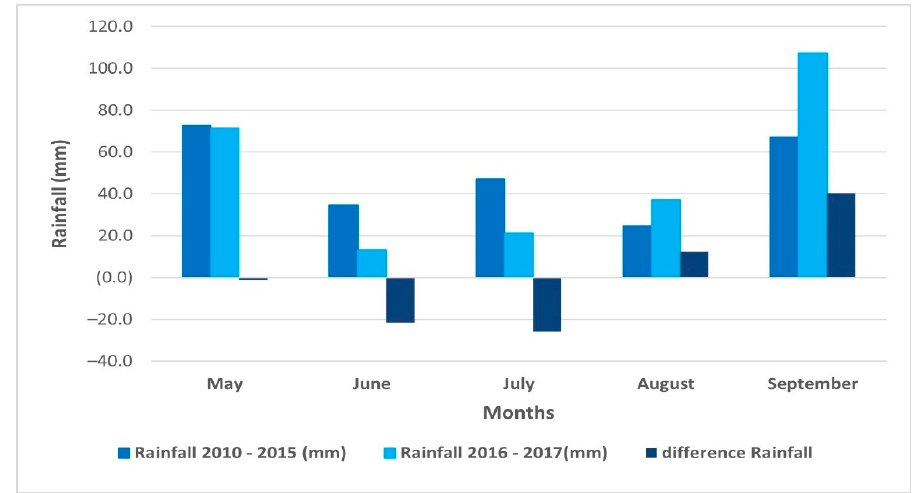
Figure 4. Comparison of monthly rainfall values recorded by the weather station of the farm.